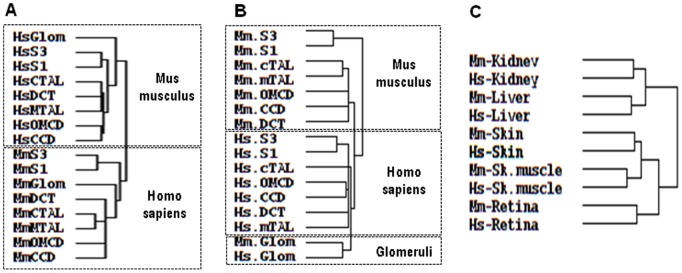
Hierarchical clustering of gene expression in human and mouse kidney sub-structures and tissues.Clustering was performed using Cluster. The dendograms showing relationships between libraries were graphically visualized using TreeView. A. Clustering according to tag abundance of the 4644 ortholog gene-specific tags present in the HMKS database discloses that the two main subgroups of structures with similar patterns of gene expression correspond to human and mouse structures respectively. B. Clustering according to relative abundance of the same tags reveals similarities between human and mouse glomuruli but not other sub-structures. C. Clustering according to relative abundance of the 5145 pairs of orthologous genes detected in different SAGE libraries from human and mouse tissues (see Table S2) reveals interspecies conservation of expression profiles.